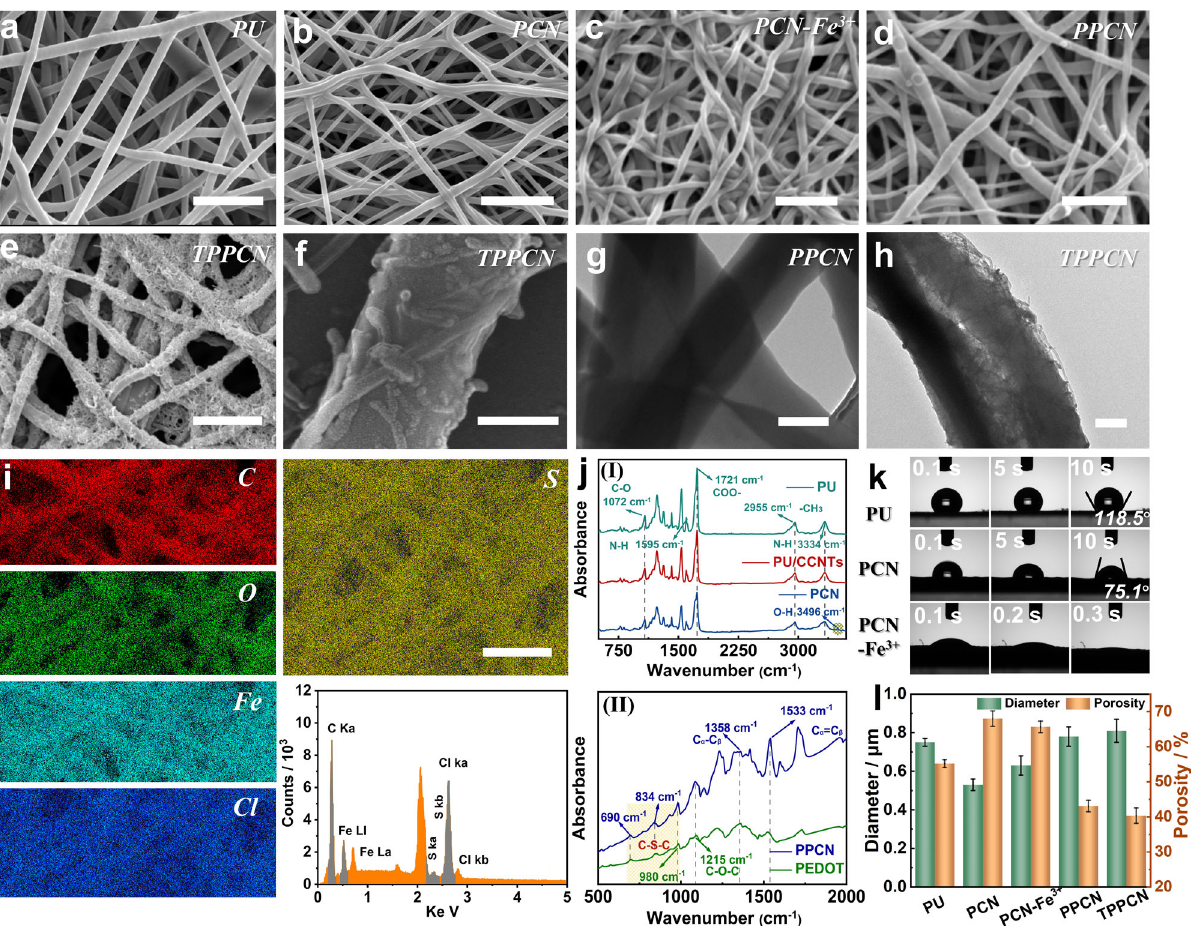
Fig. 2 Morphology and structure of prepared nano fi brous membranes. a – f SEM images of pure PU, PCN, PCN-Fe 3 + , PPCN, and TPPCN membrane, the scale bars in a – e and f are 5 μ m and 500 nm. g , h TEM images of PPCN and TPPCN membrane with core-shell structure and special morphology, both the scale bars in g and h are 500 nm. i EDS mapping results of TPPCN membrane, the scale bars in i is 5 μ m. j – l FT-IR spectrums, contact angle, diameter, and porosity of prepared membranes. The error bars presented in the plots represent the standard deviations of the respective